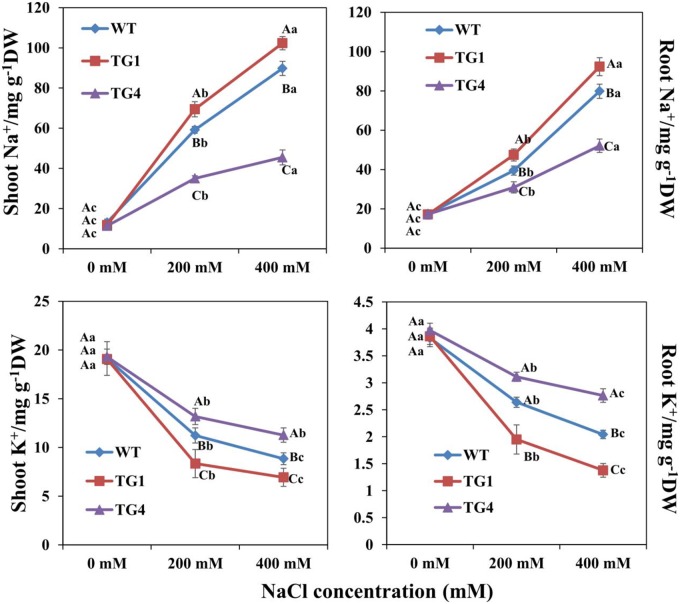
Na+, K+ contents of TG1, TG4 and WT plants under salt stress (0, 200, and 400 mM NaCl).Value are mean ± SE (n = 3). The significance of treatment (0, 200 and 400 mM NaCl concentration) an sample type (WT and transgenic plants) was tested at the P < 0.05 level (two way ANOVA), capital letter represents the difference between WT and transgenic plants under the same salt concentration, lowercase represents the difference of WT or transgenic plants under 0, 200 and 400 mM NaCl concentration.